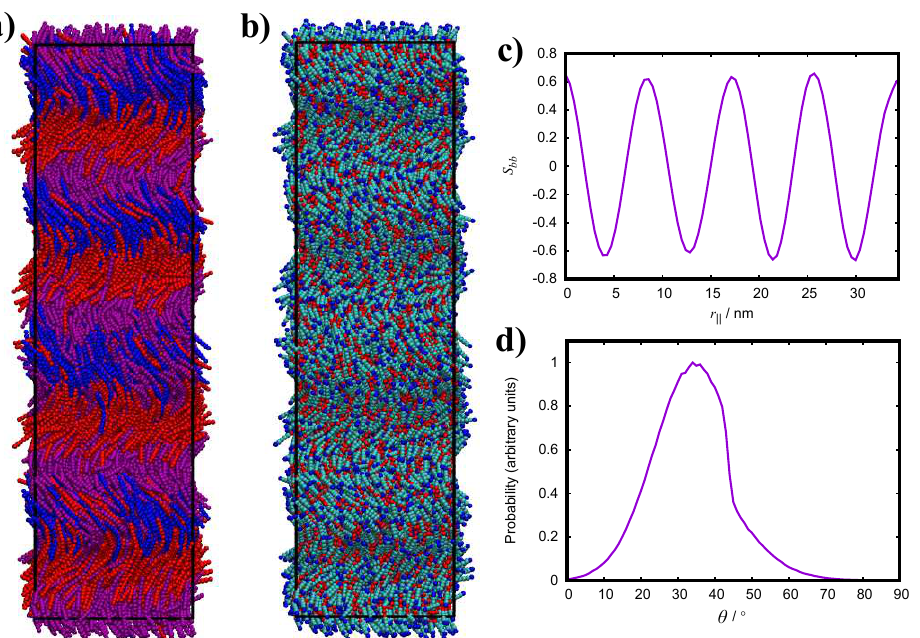
Figure 5. Simulation snapshots from a 4096 − molecule system of the FM CG model, with ( a ) orienta- tional and ( b ) bead-type colourings. ( c ) Orientational correlation ( S bb ) as a function of the helical axis, r (cid:107) , and the ( d ) distribution of the conical tilt angle, θ